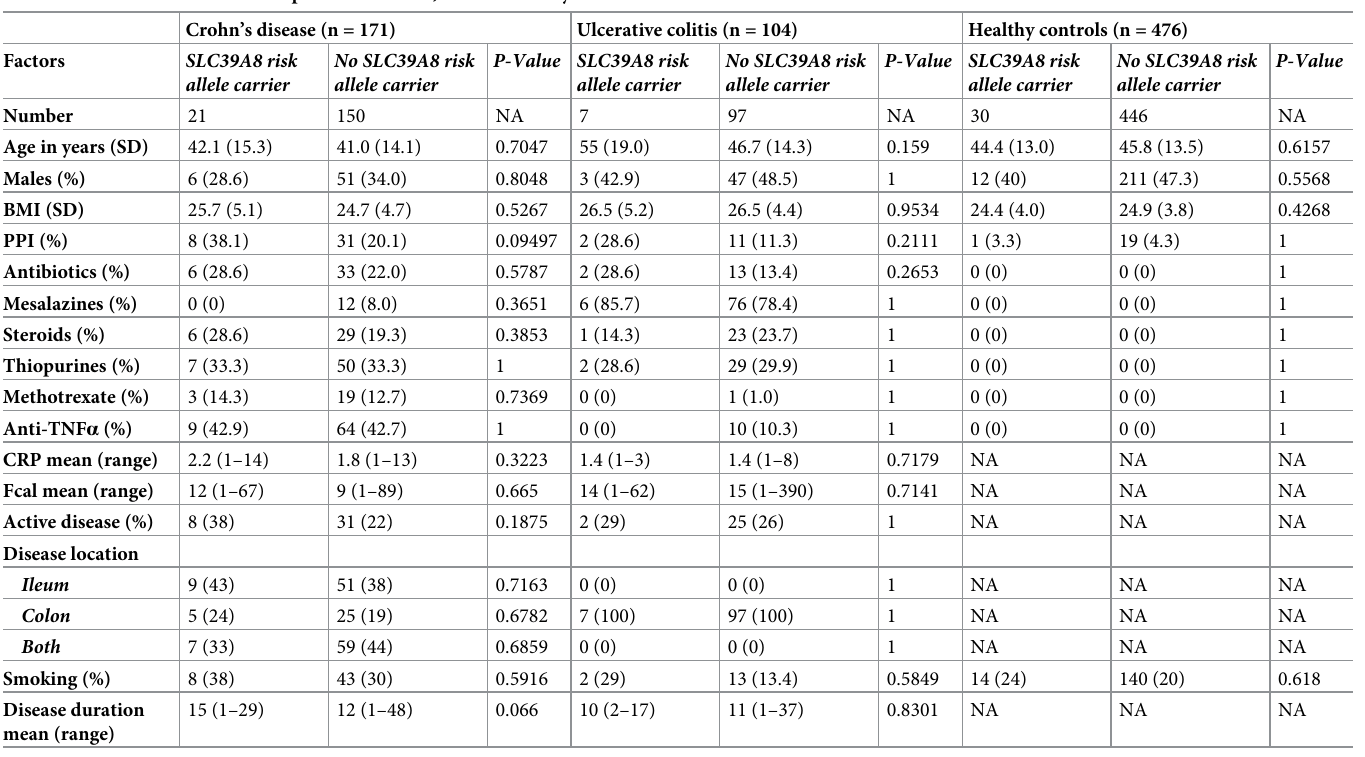
Table 1. Clinical characteristics of patients with CD, UC and healthy